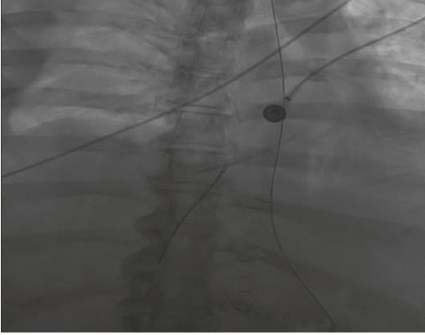
Figure 4: Catheter retrieval via snare device under